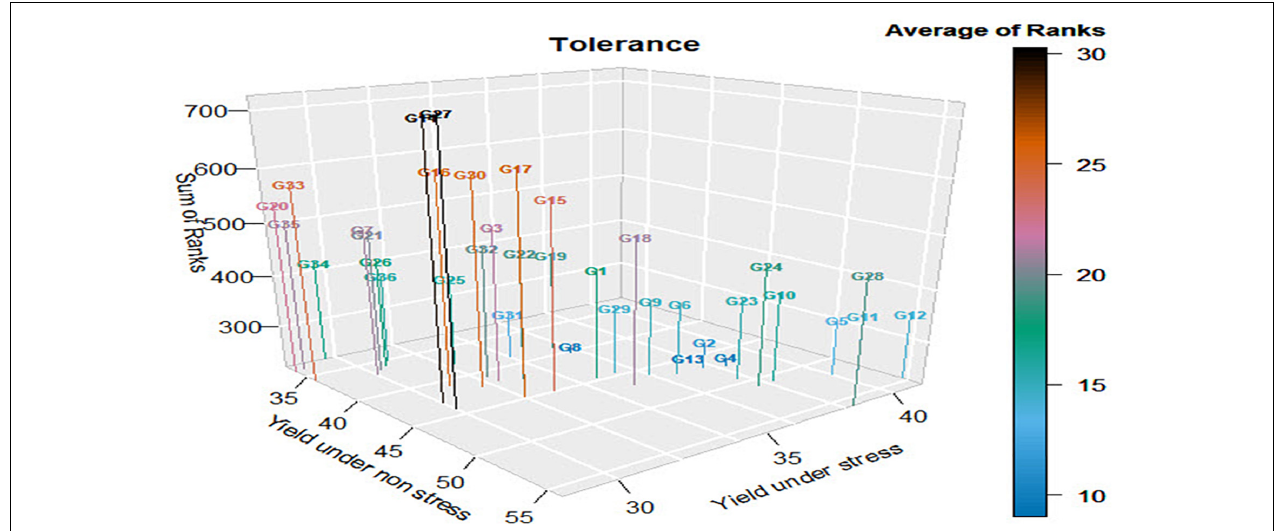
FIGURE 1 | Tolerance of genotypes according to the average rank of 22 stress indices (small number of average ranks signifies tolerance). All Gs correspond to the genotype identified in Table 6 .